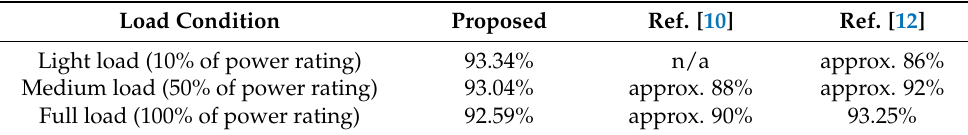
Table 5. Power loss calculations for the prototype converter at 100 Table 4. Efficiency comparison of the DAB converter with different control strategies in forward power conversion.